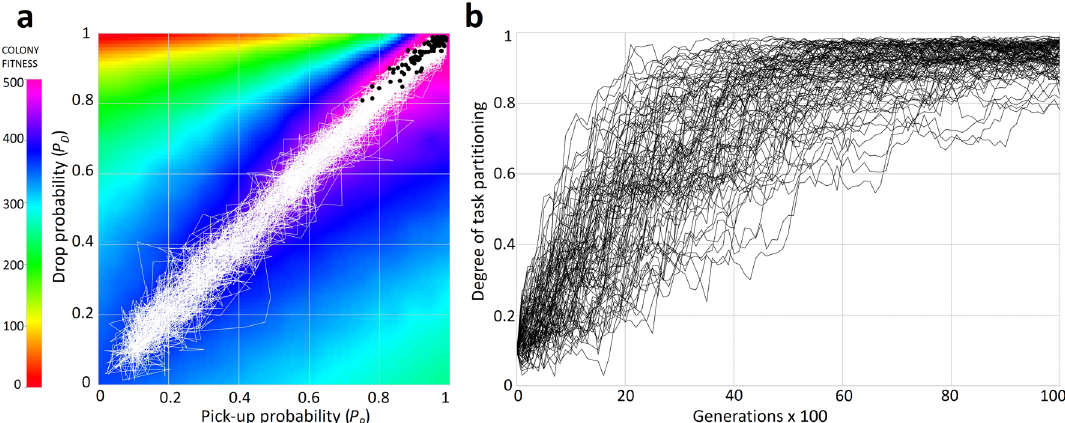
Figure 3. Evolutionary simulation. ( a ) Evolutionary trajectories (white lines) of 100 replicate simulations of 50 colony populations initialized with P P and P D between 0 and 0.2, plotted on the arboreal fitness landscape. Black dots represent evolved outcomes after 10,000 generations. ( b ) Degree of task partitioning, defined as the average between P P and P D , plotted as a function of evolutionary time for the same 100